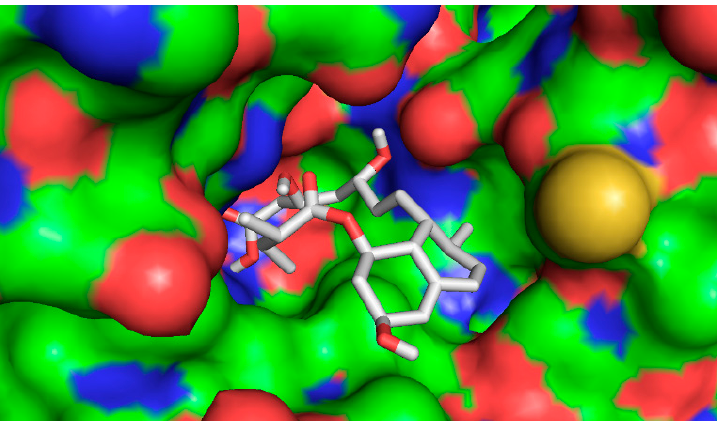
Figure 12. Bound conformer of ligands interacting with the substrate binding sites of HMGR (atorvastatin). Molecules 2016 , 21 , 404 10 of 17